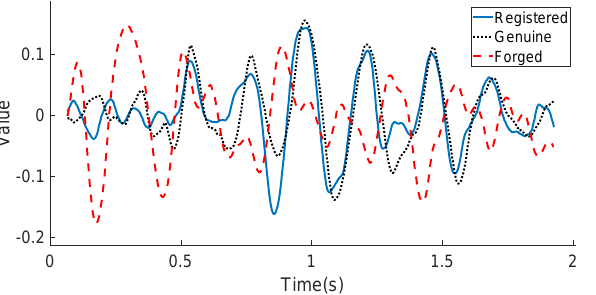
Figure 11. User’s motion sensor data example (Gyroscope-Z): registered, genuine, and forged in-air